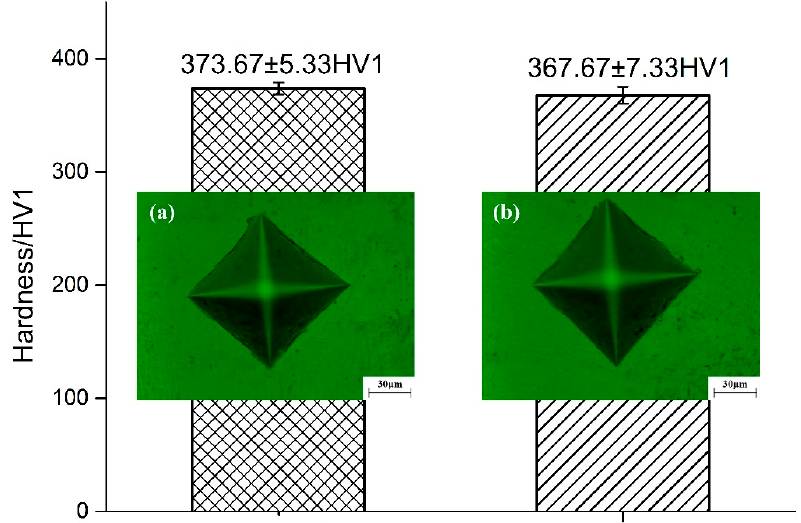
Figure 8. Measurement points and results of micro-hardness testing for the SLM Ti6Al4V sample: ( a ) before heat treatment; ( b ) after heat treatment.